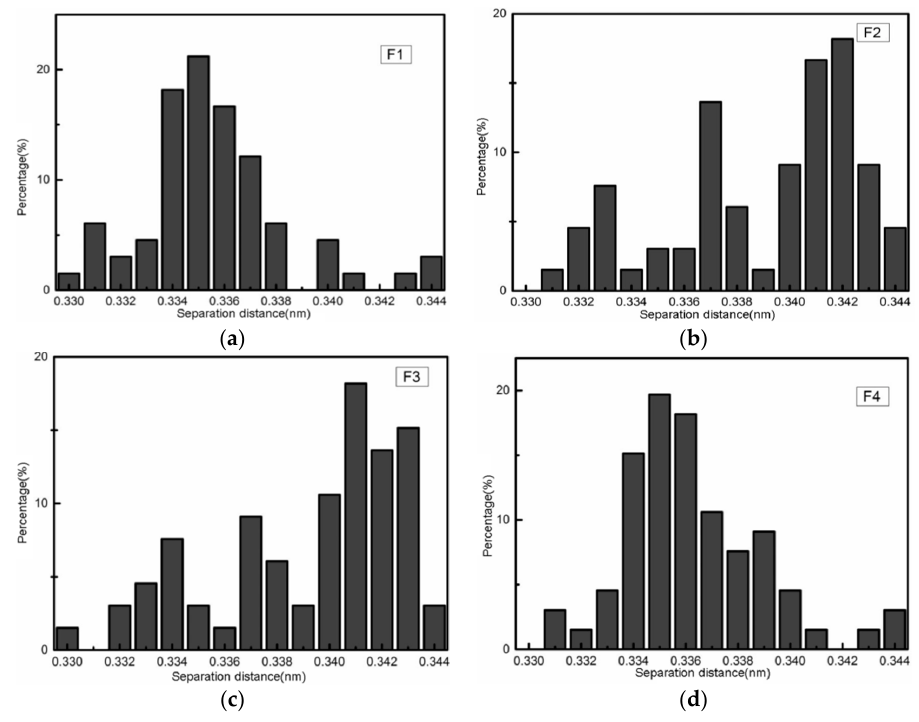
Figure 3. Initial HRTEM images at high magnification of nascent soot particles and partial enlarged images of soot particles under different conditions: ( a ) initial HRTEM image of pure ethylene; ( b ) partial enlarged image of F1; ( c ) initial HRTEM image of 1-pentanol/ethylene; ( d ) partial enlarged image of F2; ( e ) initial HRTEM image of 3-methyl-1-butanol/ethylene; ( f ) partial enlarged image of F3; ( g ) initial HRTEM image of 2-methyl-1-butanol/ethylene; ( h ) partial enlarged image of F4. Observations on the crystallite length showed that the addition of pentanol isomers could slow down the growth of graphitization of the nascent soot particles from ethylene inverse diffusion flames. Moreover, the pentanol additions maintained the fringe length at shorter levels, and increased the degree of disorder of the microcrystal array. 1-Pentanol and 3-methyl-1-butanol additions significantly reduced the degree of graphitization of soot particles. Most of the soot particles from 1-pentanol and 3-methyl-1-butanol-doped flames presented fringe lengths in the 1–2 nm range, while the effects of 2-methyl-1-butanol on reducing the degree of graphitization of primary soot particles were not obvious. The crystallite length of pure ethylene and 2-methyl-1-butanol/ethylene soot particles were similar at about 10 nm. Partial enlarged HRTEM images of nascent soot particles are shown on the right of Figure 3, where the enlarged boxes all have the same 10 nm width. In addition, the statistic results of separation distance distribution of nascent particles are shown in Figure 4. In selected statistical fringe layers, the separation distance of the pure ethylene flame soot particle was concentrated around 0.336 nm, and the fringe layers of the separation distance between 0.334–0.337 nm accounted for 68.18% of the particles. In 1-pentanol/ethylene and 3-methyl-1-butanol/ethylene soot particles, the distribution peaks of the separation distance both shifted to the right side, and the fringe layers of the separation distance between 0.334–0.337 nm accounted for 21.21% and 23.27%, respectively, which showed an increasing trend in the separation distance. However this trend was not obvious in 2-methyl-1-butanol/ethylene soot. As shown in Figure 4, the distribution peak of the 2-methyl-1-butanol/ethylene soot separation distance was similar to that in pure ethylene particle, and the fringe layers of the separation distance between 0.334–0.337 nm accounted for 63.64%. The similarities in the distributions of fringe separation distance between F1 and F4, F2 and F3 also verified that the fringe lengths of F1 and F4, F2 and F3 shown in Figure 3 were similar.